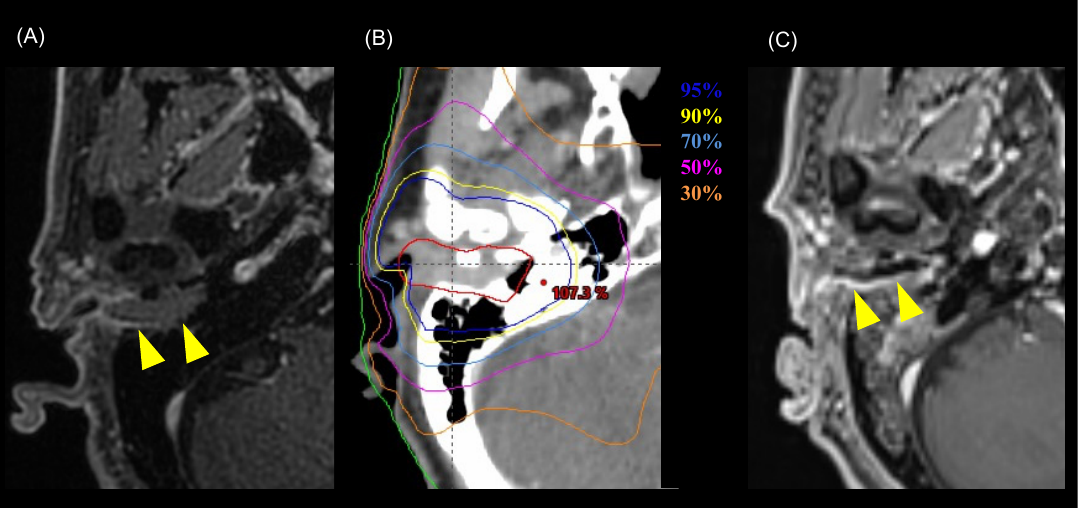
Figure 2. Representative images of a patient with T3 disease who was cured by chemoradiotherapy (Patient number 9 in Table 2). ( A ) MRI image before treatment. Yellow arrowheads indicate the tumor. ( B ) Dose distribution of the radiotherapy (intensity-modulated radiotherapy) on axial CT images. Highlighted are: 95% (blue), 90% (yellow), 70% (cyan), 50% (pink), 60% (magenta), 50% (purple), and 30% (orange) isodose curves (100% = 70 Gy). The red line shows the gross tumor volume. ( C ) MRI image six months after treatment. The tumor has shrunk and is not observable macroscopically. Yellow arrowheads indicate the tumor.